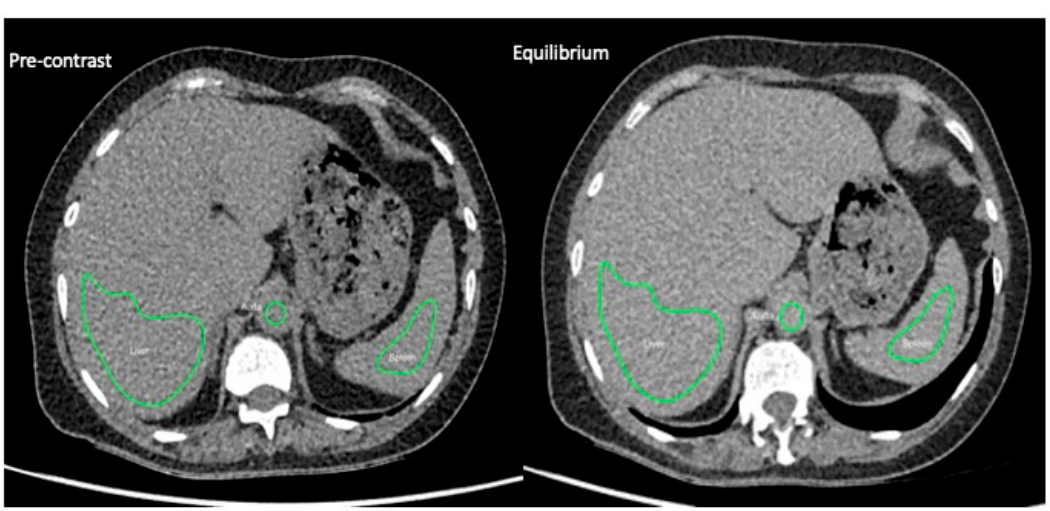
Figure 2. EQ-CT images pre- and at EQ-contrast phase through the upper abdomen, showing example regions of interest drawn in the liver, spleen, and abdominal aorta. (EQ-CT: equilibrium contrast- enhanced CT; EQ: